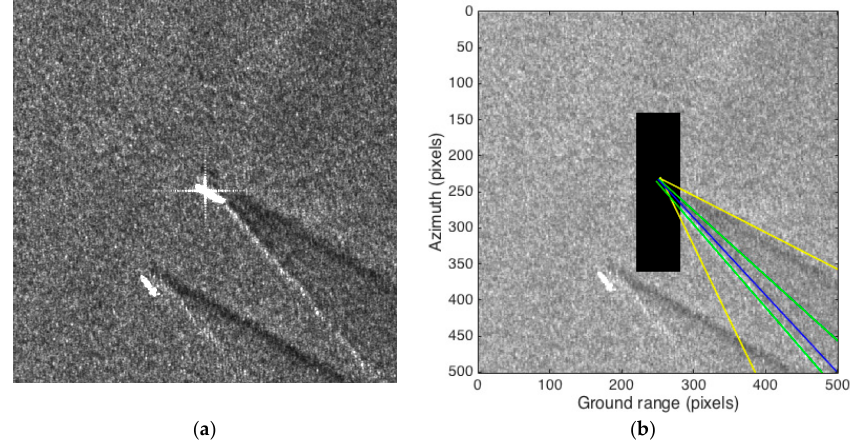
Figure 7. ( a ) Stripmap Sentinel-1 image (wake #1 in Table 2); ( b ) Reconstructed wake. Only the true features are displayed. The turbulent wake is shown in blue, the narrow-V wake in green, and the Kelvin arm in yellow. The black rectangle includes the masked pixels, excluded from the detection process.